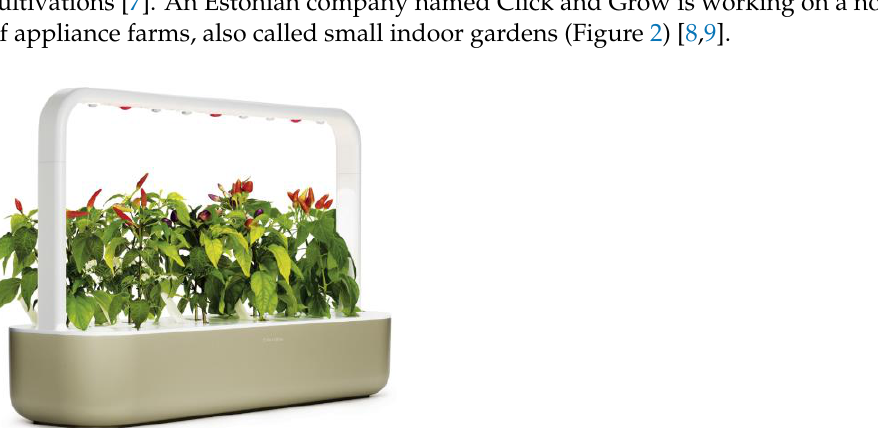
Figure 2. An appliance farm for indoor farming [9]; Copyright permission: License Number: 5423060894672; License date: 6 November 2022; Licensed Content Publisher: Elsevier.